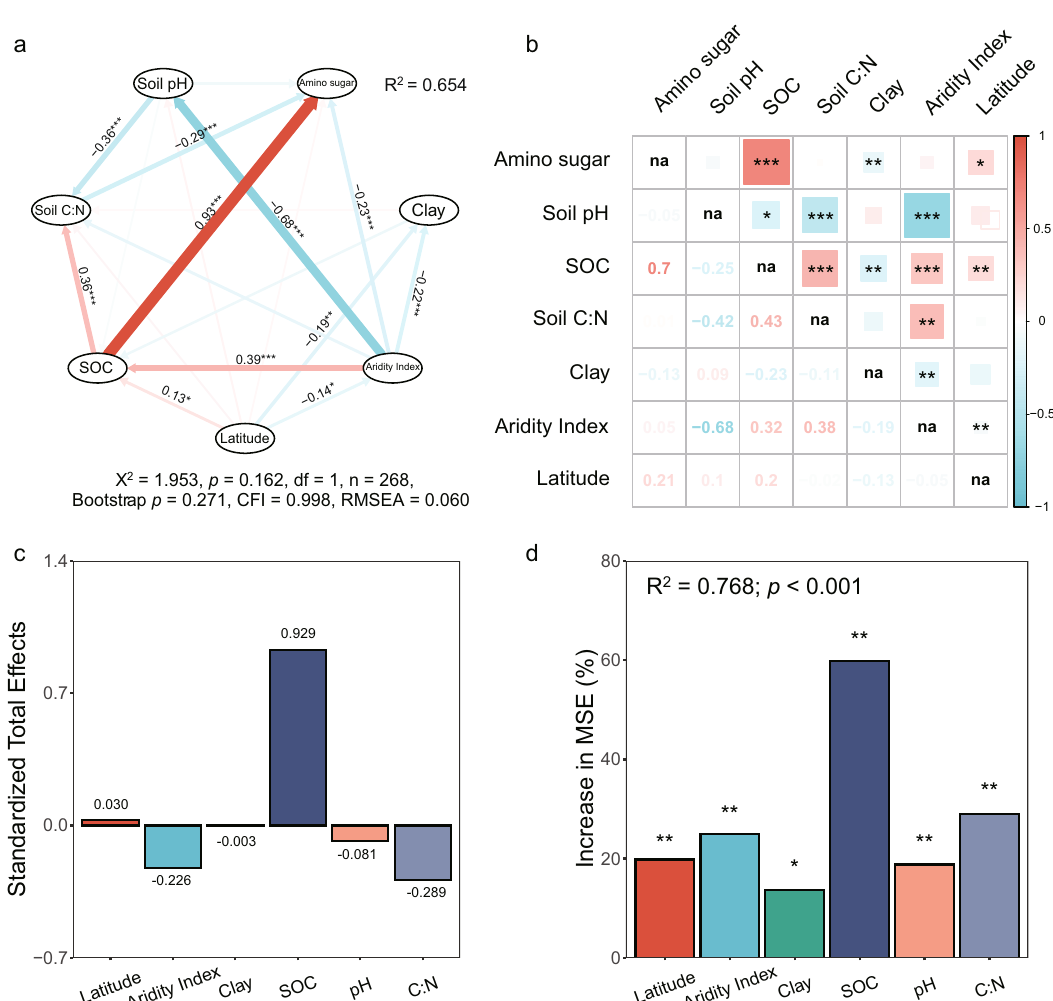
Fig. 2 Models of relationships between environmental variables and amino sugars on a global scale. a Structural equation model (SEM). b Correlations between environmental variables. c Standard total effect of SEM. d Random Forest model, which shows average predictive importance (mean square error (MSE) increase percentage) for each environmental factor for absolute content of soil amino sugars. SEM shows the causality and correlation between the absolute content of amino sugars in soil and the environmental variables. Red lines indicate positive effects; blue lines indicate negative effects. The thickness and color of the lines are directly proportional to the standardized path coef fi cient on the single arrow. SOC soil organic carbon. R 2 represents the variance of biomarkers explained by the model. Asterisks indicate the signi fi cance of each predictor, with one and two asterisks indicating p < 0.05 and p < 0.01, respectively.